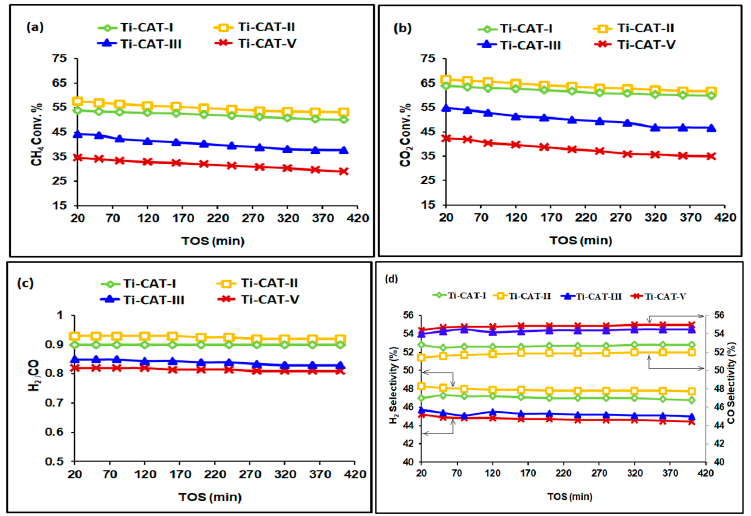
Figure 4. Catalytic performance of Ti-CAT-I, Ti-CAT-II, Ti-CAT-III, and Ti-CAT-V ( a ) CH 4 conversion ( b ) CO 2 conversion and ( c ) H 2 /CO ratio and ( d ) H 2 , CO